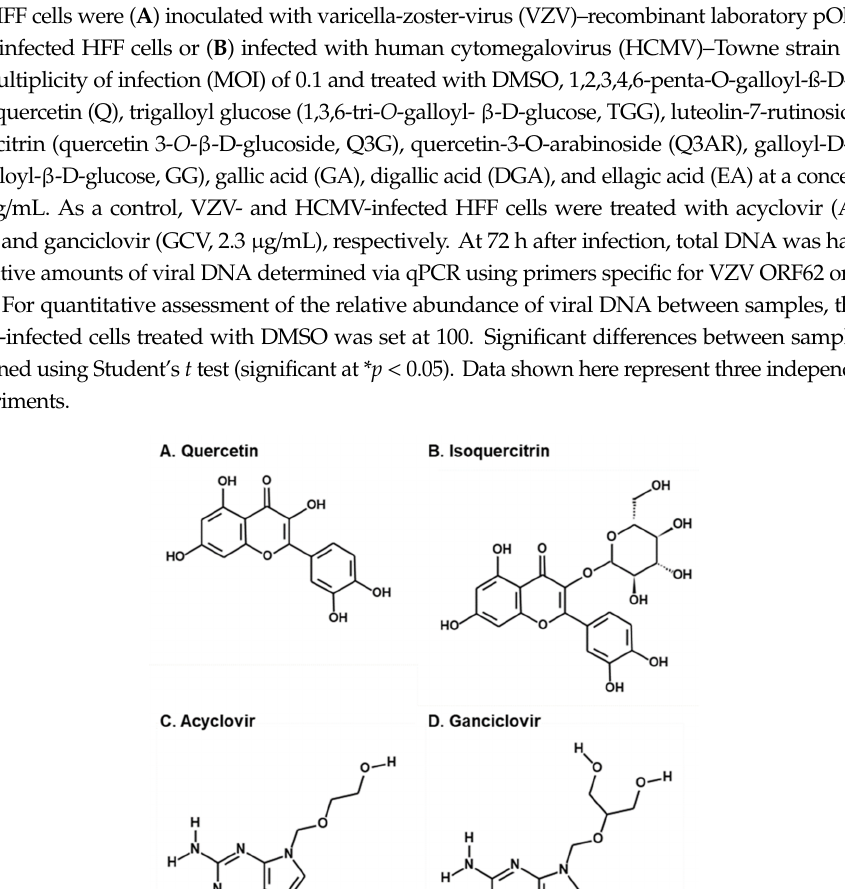
Table 1. Average 50% inhibitory-concentration ( IC 50 ) values for antiviral activities of quercetin and isoquercitrin against VZV and HCMV.